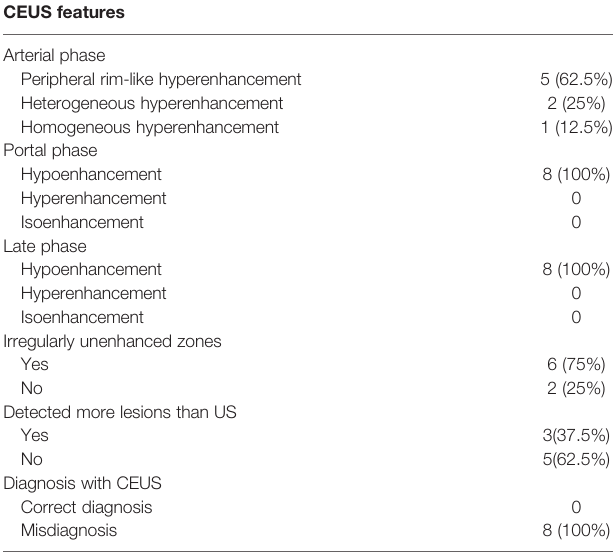
FIGURE 3 | CEUS features of HEHE in a 29-year-old female. (A) Greyscale ultrasound illustrated a subcapsular hypoechoic lesion (arrows) in the left hepatic lobe. (B) In the arterial phase (12 s), the lesion showed heterogeneous hyperenhancement (arrows) with central unenhanced area. (C) The lesion washed out quickly and presented hypoenhancement (arrows) in the portal phase (67 s). (D) The lesion demonstrated marked hypoenhancement (arrows) in the late phase (174 TABLE 3 | The CEUS features of HEHE in 8 patients.